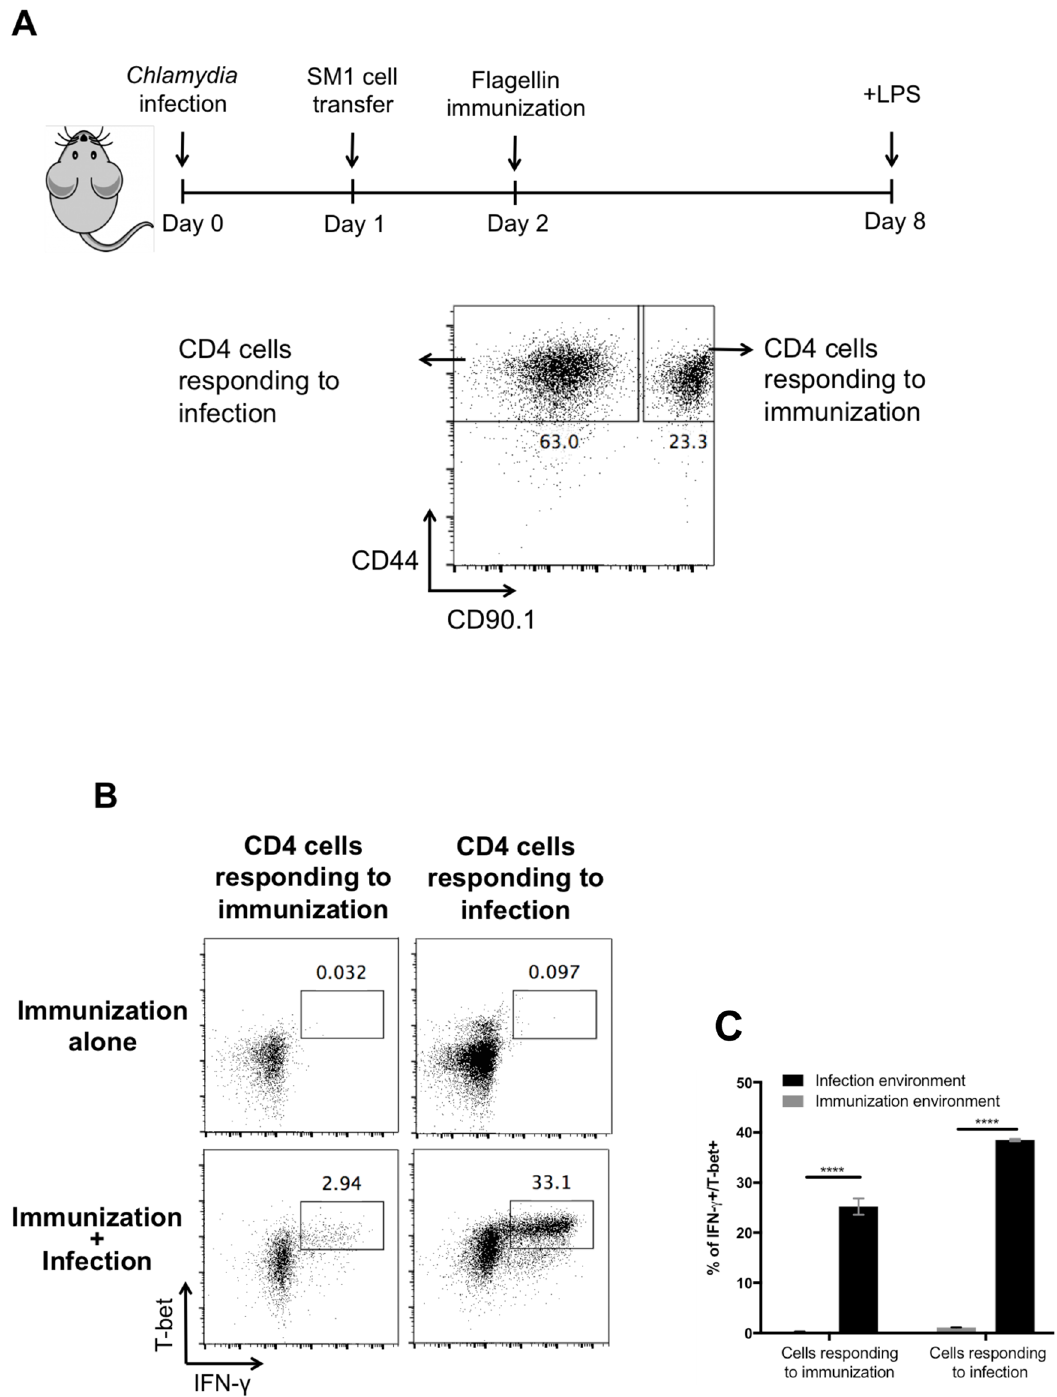
Fig 6. Th1 cells generated by immunization respond weakly in infected environment. (A) C57BL/6mice were infected i.v. with 1 × 10 7 Chlamydia muridarum . On the followingday, CD90.1 SM1 cells were transferred adoptively into infected or uninfectedmice at the dose of 0.5 × 10 6 cells/mouse. Flagellinimmunizationwas performed intravenously one day after SM1 cell transfer, 1ug flagellin/mouse. At day 8 postinfection, 10ugLPS was administered i.v., and spleenswere collected4 hours later to determineIFN- γ production by SM1 cells (CD90.1+) and endogenousCD4 T cells (CD90.2) by flow cytometry. (B) Representative flow cytometry plots and (C) a graph of combineddata are shown. Data shownwere combinedfrom two experimentscontainingat least three mice per group. Statistical analyseswere performed by two-way ANOVA with a Bonferroni posttest. Error bars represent the mean ± SEM. p < 0.0001 ( **** ),0.0002 ( *** ), 0.0021 ( ** ), 0.0332( * ),